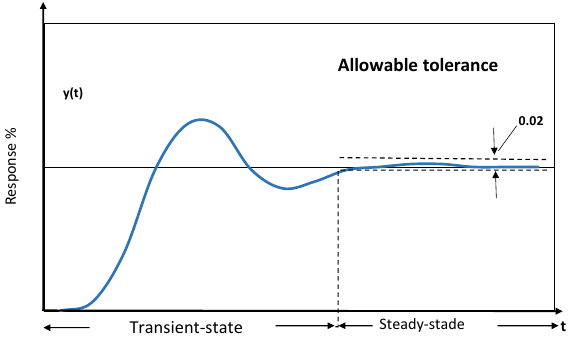
Figure 2. States in dynamic step Figure 2: States in dynamic step response.